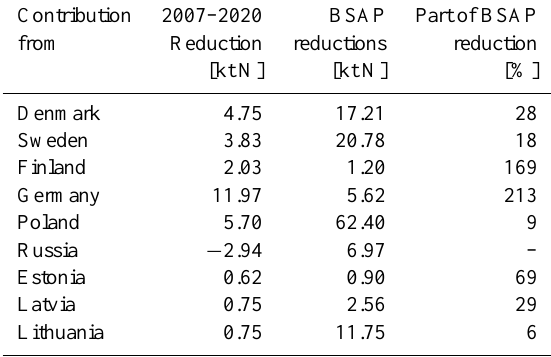
Table 4. The projected reduction in nitrogen deposition compared to the required nitrogen input reduction in the provisional Baltic Sea Action Plan (BSAP) country allocation